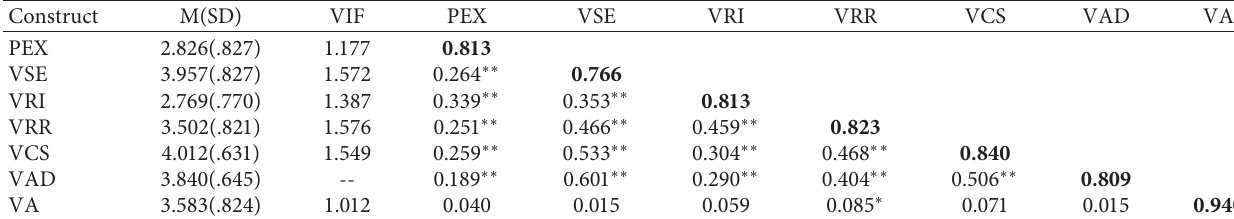
Table 4: Correlation scores and external validity test.